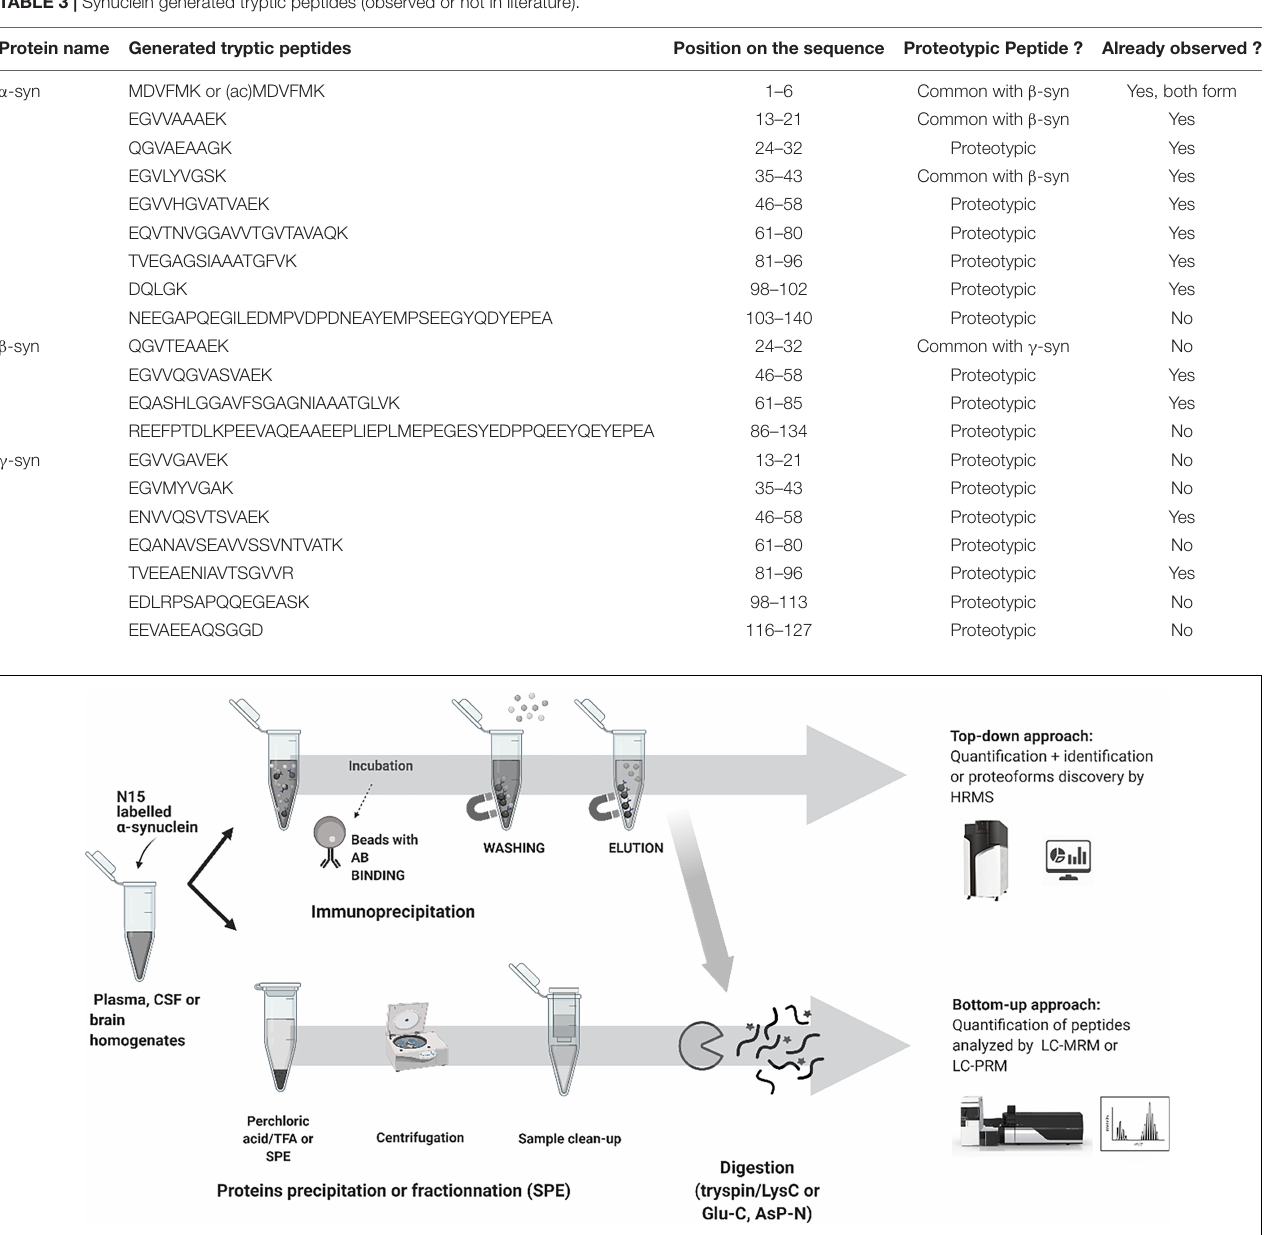
FIGURE 3 | Typical workflow used for synuclein analysis by LC-MS.